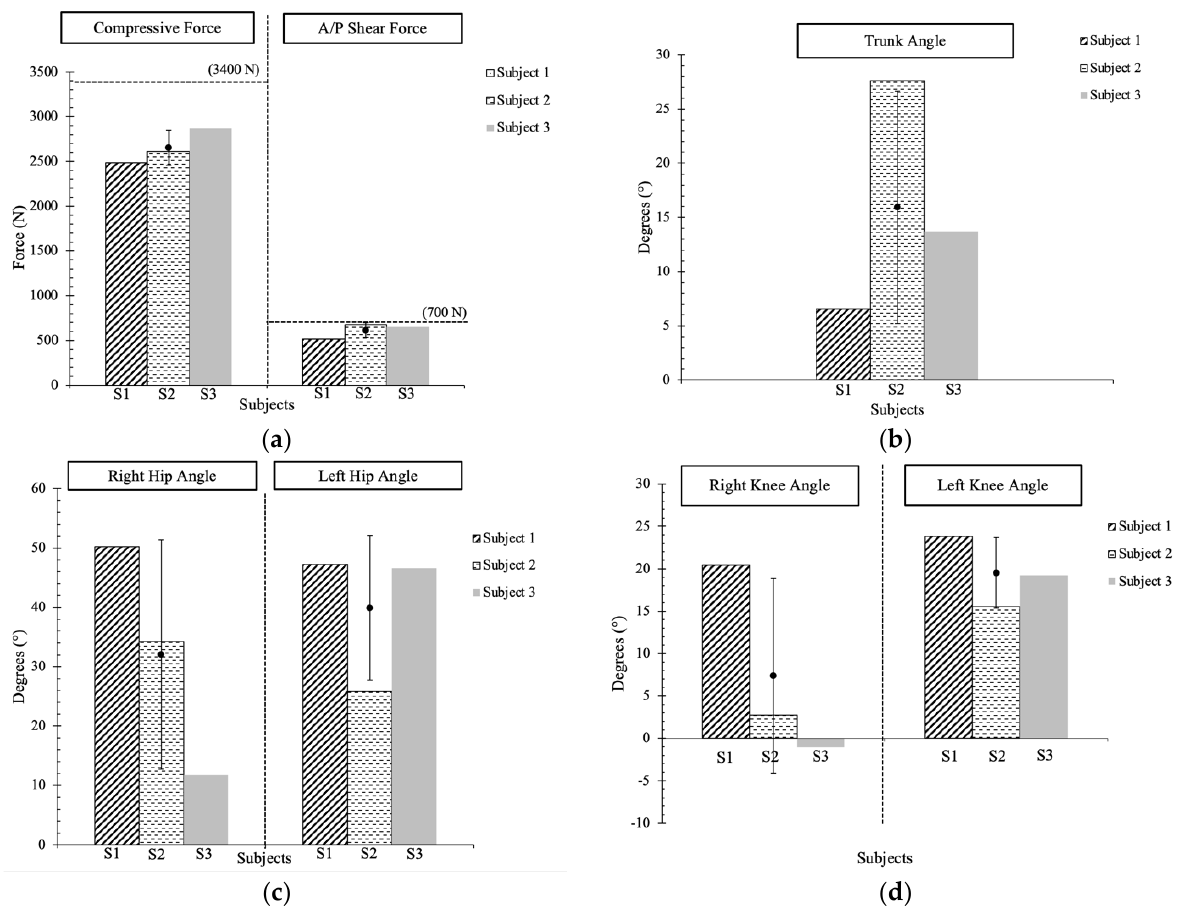
Figure 5. The analyzed results at Pose#1 in Task#1: ( a ) the exposed spinal forces with the recom- mended safety threshold values; ( b ) the trunk angles; ( c ) the hip angles; ( d ) the knee angles.